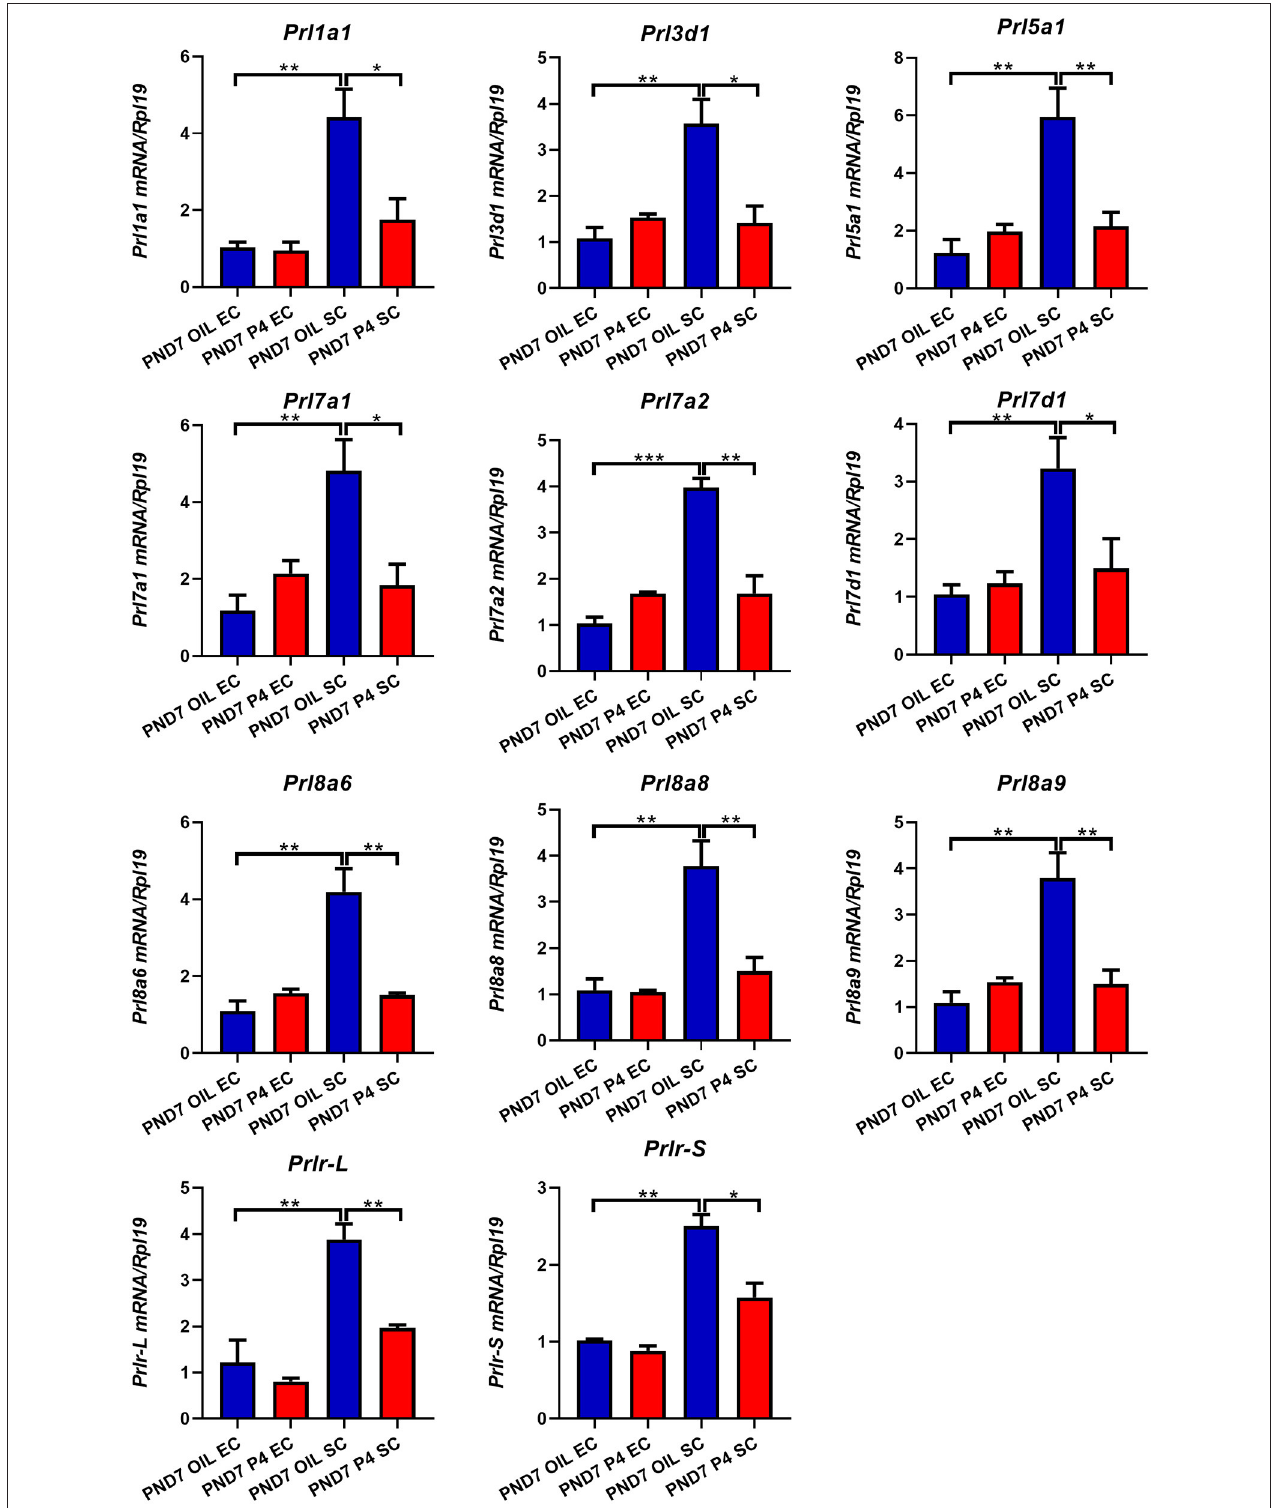
FIGURE 6 | Quantitative Real-time-PCR analysis of Prl1a1 , Prl3d1 , Prl5a1 , Prl7a1 , Prl7a2 , Prl7d1 , Prl8a6 , Prl8a8, Prl8a9 , and Prlr ( Prlr-L and Prlr-S ) mRNA levels in epithelium or stroma on PND7. Prl1a1 , Prl3d1 , Prl5a1 , Prl7a1 , Prl7a2 , Prl7d1 , Prl8a6 , Prl8a8 , Prl8a9 , Prlr ( Prlr-L and Prlr-S ) genes were mainly expressed in the stroma and inhibited after P4 injection on PND7. Results are means ± SEM ( n = 5). Bars with different superscripts are significantly different ( P < 0.05).